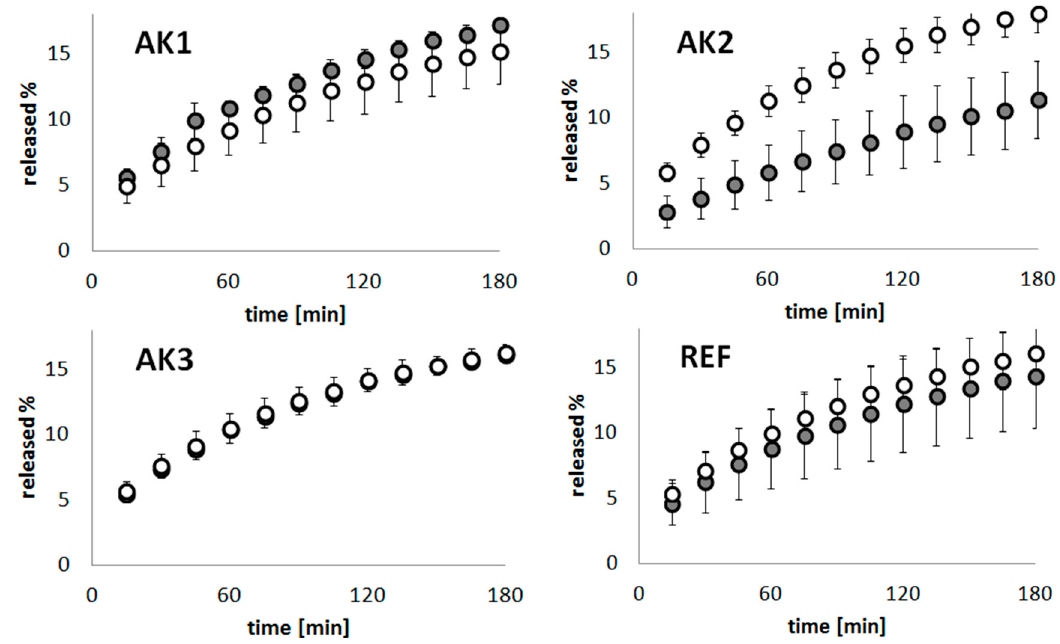
Figure 4. Release profiles of naproxen sodium (NS), at 22 °C (filled circle) and at 42 °C (empty circle) from the formulations AK1, AK2, AK3 and from the reference gel (REF); the Y-bars represent standard deviation.